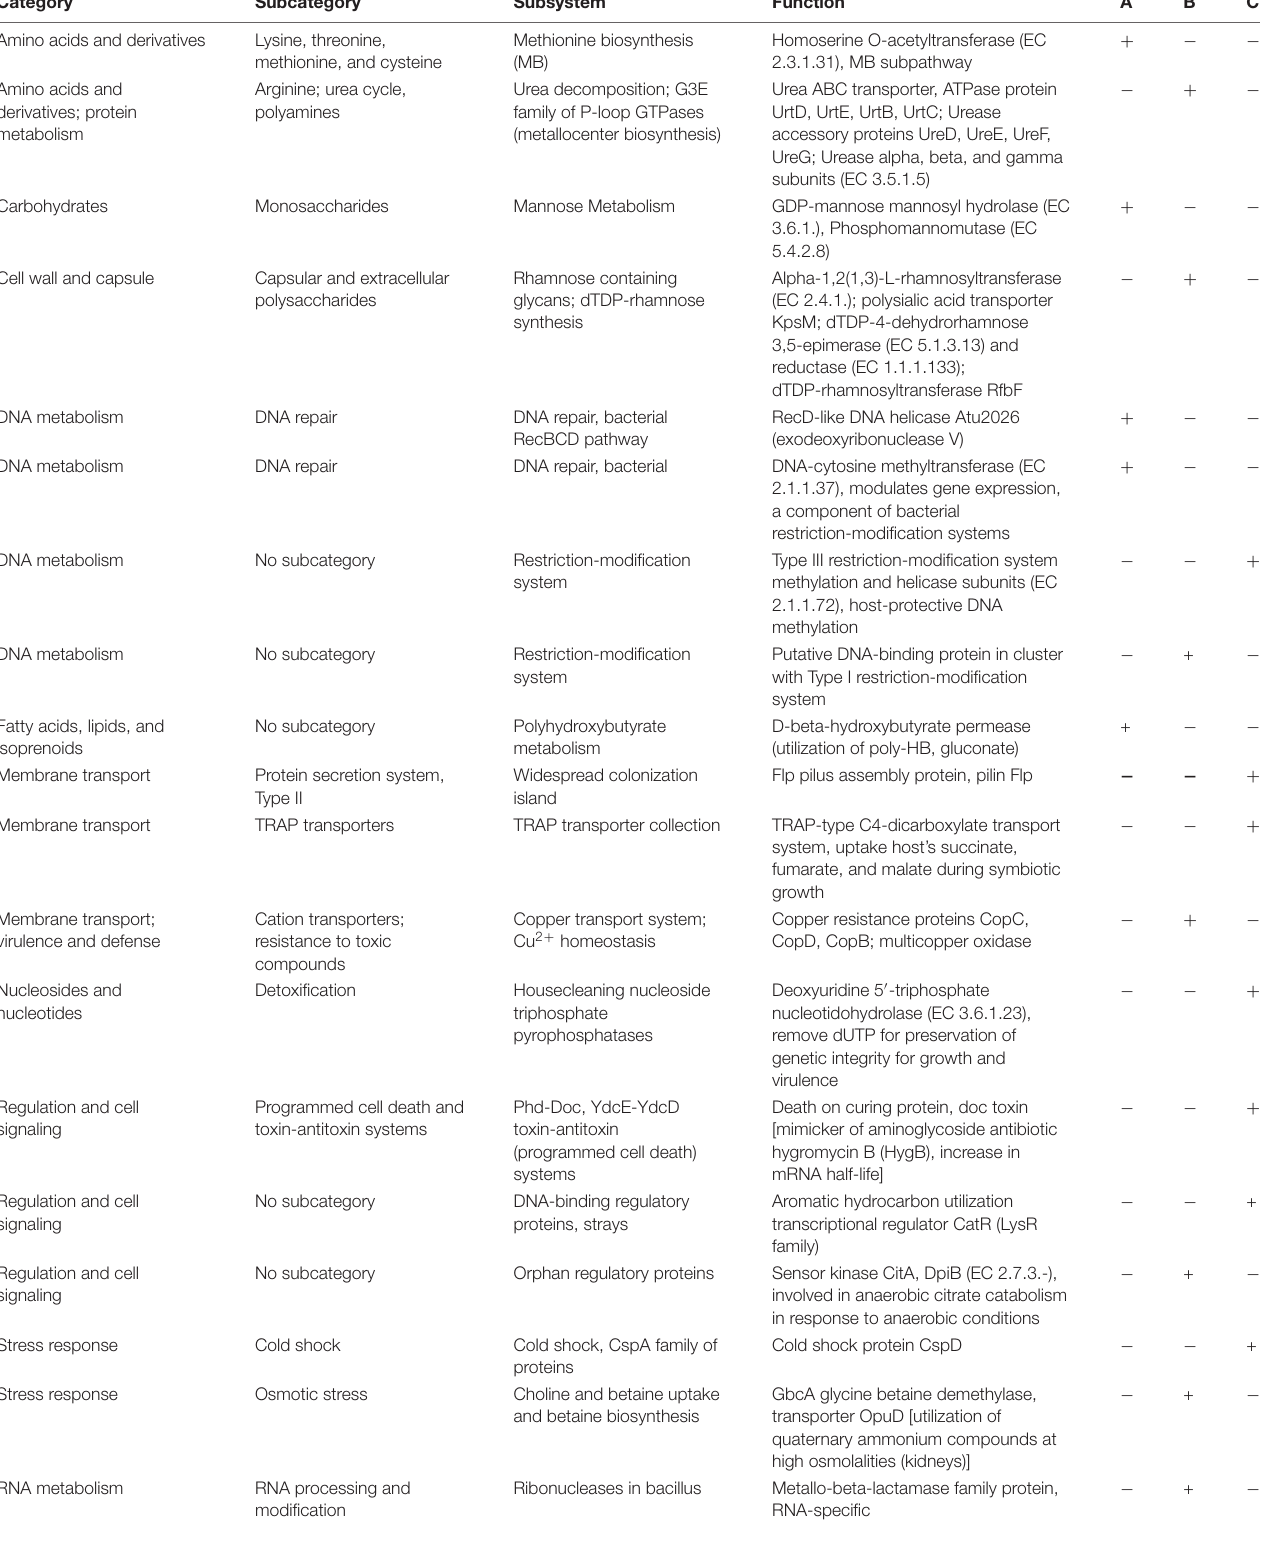
TABLE 4 | Genome-based comparison for the presence/absence of metabolic subsystem functions in Pseudoalteromonas sp. 16-SW-7 (A), P. distincta ATCC 700518 T (B), and P. paragorgicola KMM 3548 T (C).